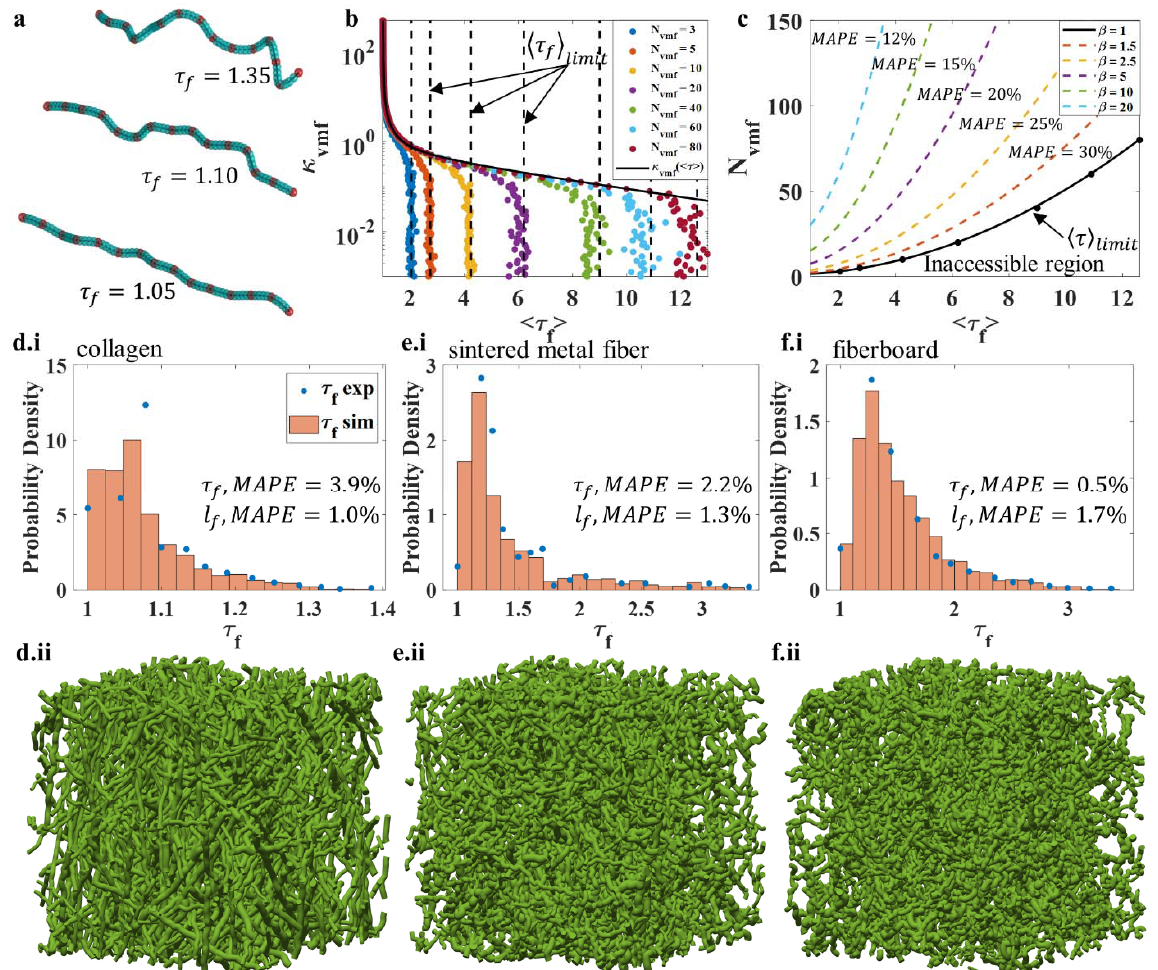
Figure 3. Controlling the tortuosity of VMF random walks: ( a ) Three randomly generated curves with varying tortuosity. Red spheres denote a step from the random walk, while blue spheres are points with added cubic splines. ( b ) The relationship between expected fiber tortuosity and orientation strength κ VMF . ( c ) How the number of steps in the random walk affects the possible fiber tortuosity and the mean absolute percentage error between the resulting tortuosity and the expected tortuosity. ( di – fii ) Empirical fiber tortuosity distributions modelled using the VMF random walk and criteria for selecting 𝜅 (cid:3023)(cid:3014)(cid:3007) and 𝑁 (cid:3023)(cid:3014)(cid:3007) ( 𝛽 = 20 ) for ( d.i , d.ii ) collagen, ( ei , e.ii ) sintered metal fi-